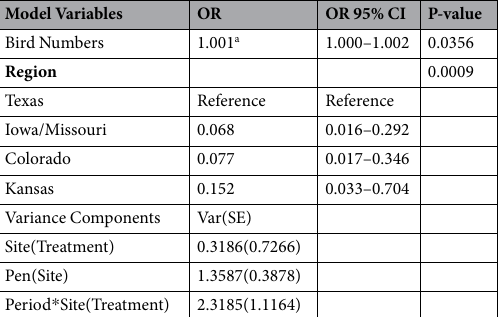
Table 1. Odd ratios from multivariable mixed-effects logistic regression model used to test the association between total bird numbers and cattle fecal shedding of ciprofloxacin-resistant Escherichia coli . a Odds ratio report the odds of per 100 birds observed on feedlots.